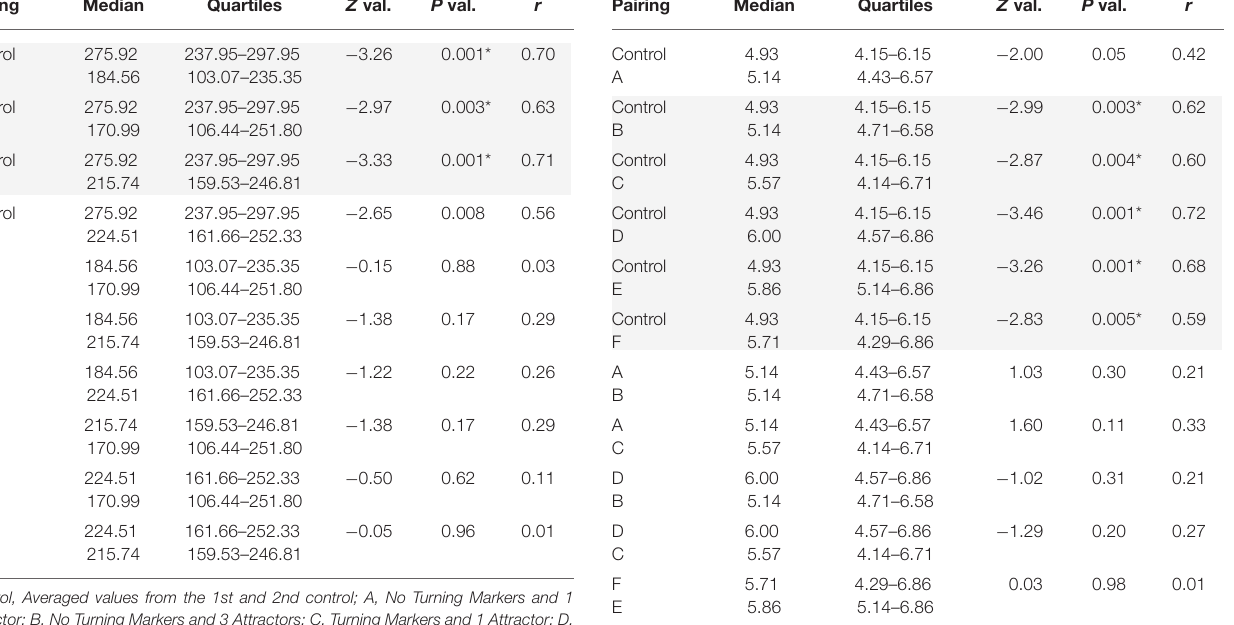
TABLE 4 | Time spent following specific attractor set in seconds.